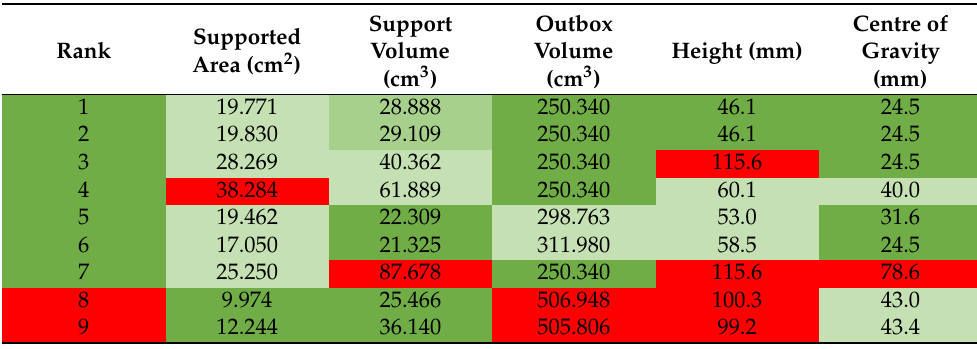
Figure 7. 3D print position orientation using Autodesk Netfabb software (the gray arrows indicate the powder-laying direction). Table 3. Choosing the orientation of the